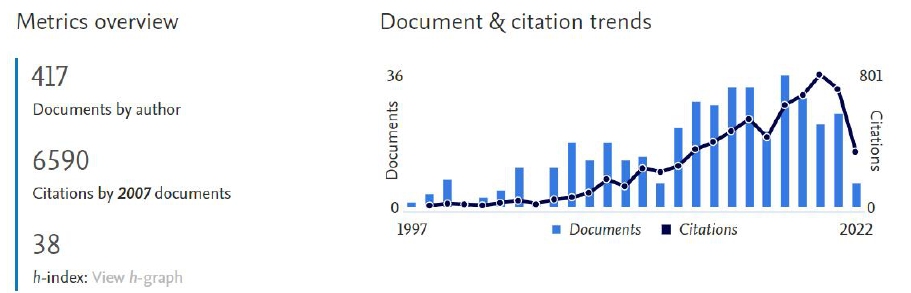
Figure 3. Statistics from Qi’s Scopus profile dated on 2 August